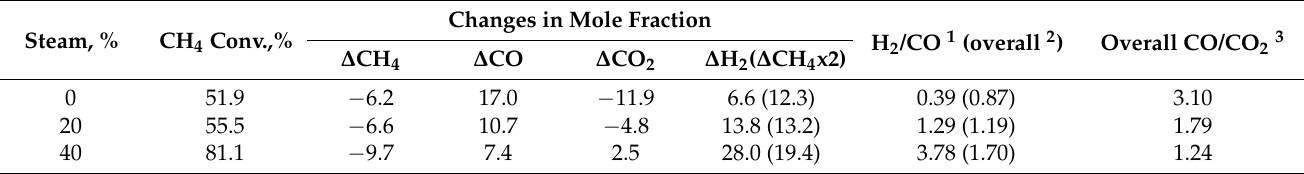
Table 2. The effect of steam concentration during the SCR of